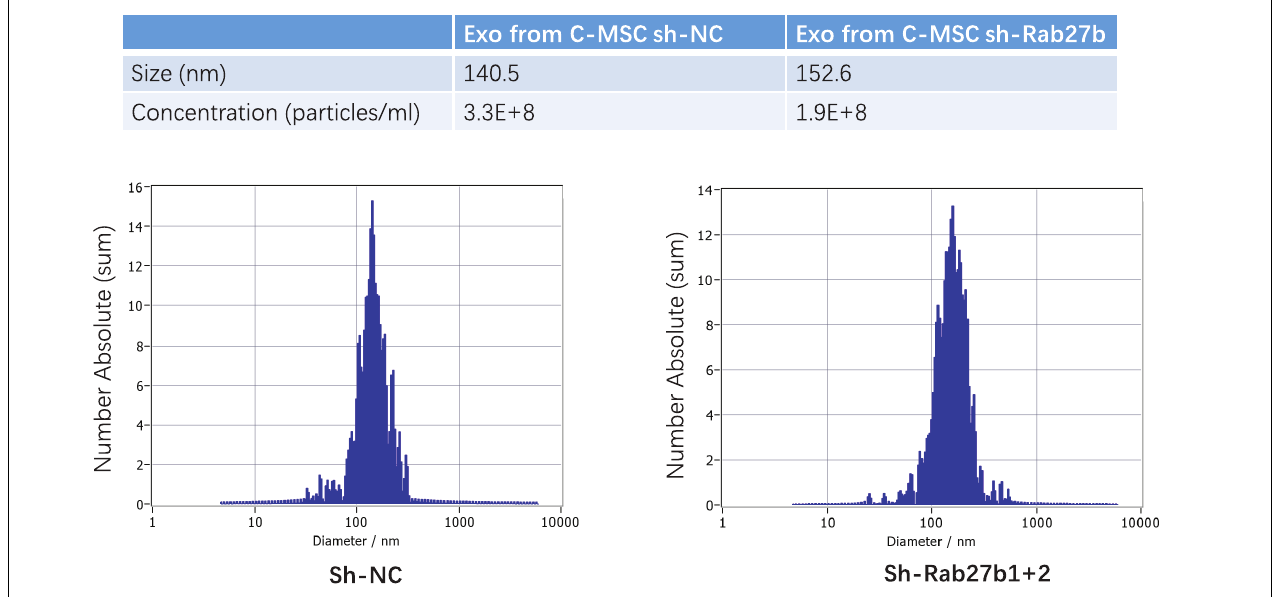
FIGURE 3 | Characterization of exosomes derived from C-MSC sh − NC and C-MSC sh − Rab27b1 + 2 . Particle concentration and size distribution in purified particles are consistent with the size range of exosomes (average size, 140–150 nm), as measured by ZetaView R (cid:13) Particle Tracking Analyzer.